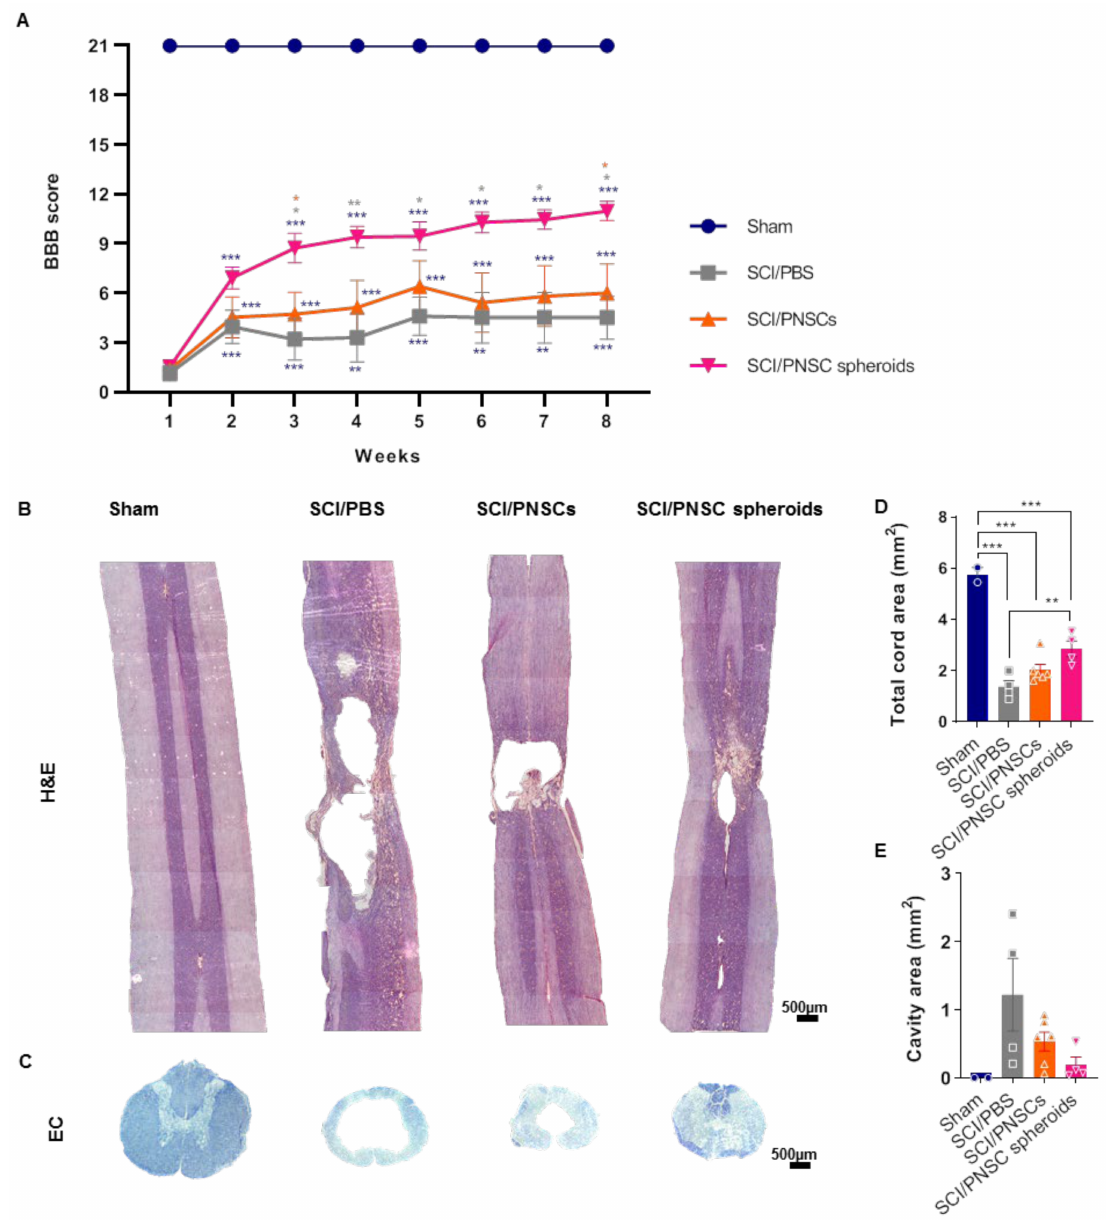
Figure 4. Peripheral nerve-derived stem cell (PNSC)-mediated functional recovery and neuronal regeneration. ( A ) BBB scoring after SCI in all groups (Sham, SCI/PBS, SCI/PNSCs, and SCI/PNSC spheroids). A two-way ANOVA with Holm– Š í d á k’s multiple comparisons was used for data analysis. ( B ) Hematoxylin and eosin staining of longitudinal spinal cord sections in all groups for assessment of tissue regeneration. ( C ) Eriochrome cyanine (EC) staining of spinal cord cross sections for myelin in all groups. ( D ) Total cord area remaining using EC imaging in Sham ( n = 3), SCI/PBS ( n = 4), SCI/PNSCs ( n = 6), and SCI/PNSC spheroids ( n = 4) animals. Ordinary one-way ANOVA with Tukey’s multiple comparisons was used for analysis. ( E ) Total cavity area from EC imaging. Ordinary one-way ANOVA with Tukey’s multiple comparisons was used for analysis. All data are expressed as mean ± S.E.M.; * p < 0.05, ** p < 0.01, and *** p <